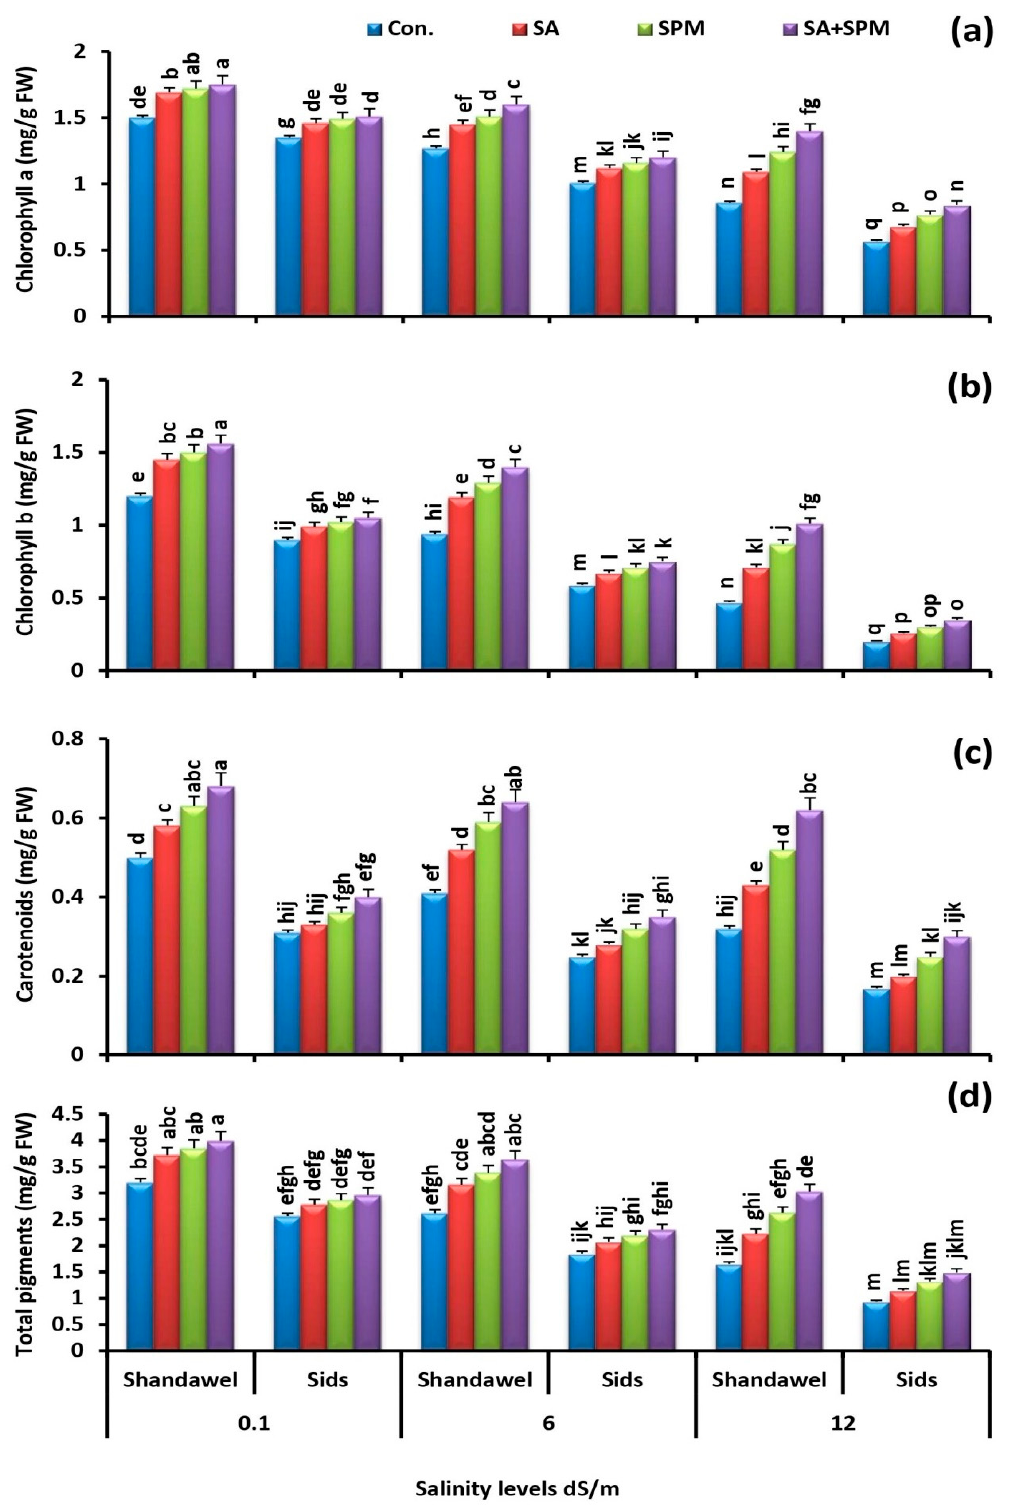
Figure 3. Influence of salicylic acid (SA; 100 mgL − 1 ) and/or spermine (SPM; 30 mgL − 1 ) on the concentration of ( a ) chlorophyll a , ( b ) chlorophyll b , ( c ) carotenoids, and ( d ) total pigments in leaves of two wheat cultivars (Shandawel 1 and Sids 14) grown under 0.1, 6, and 12 dS m − 1 salinity levels. Data are mean of four replicates (n = 4). Different letters indicate significant differences at ( p < 0.05) level according to Duncan’s test.